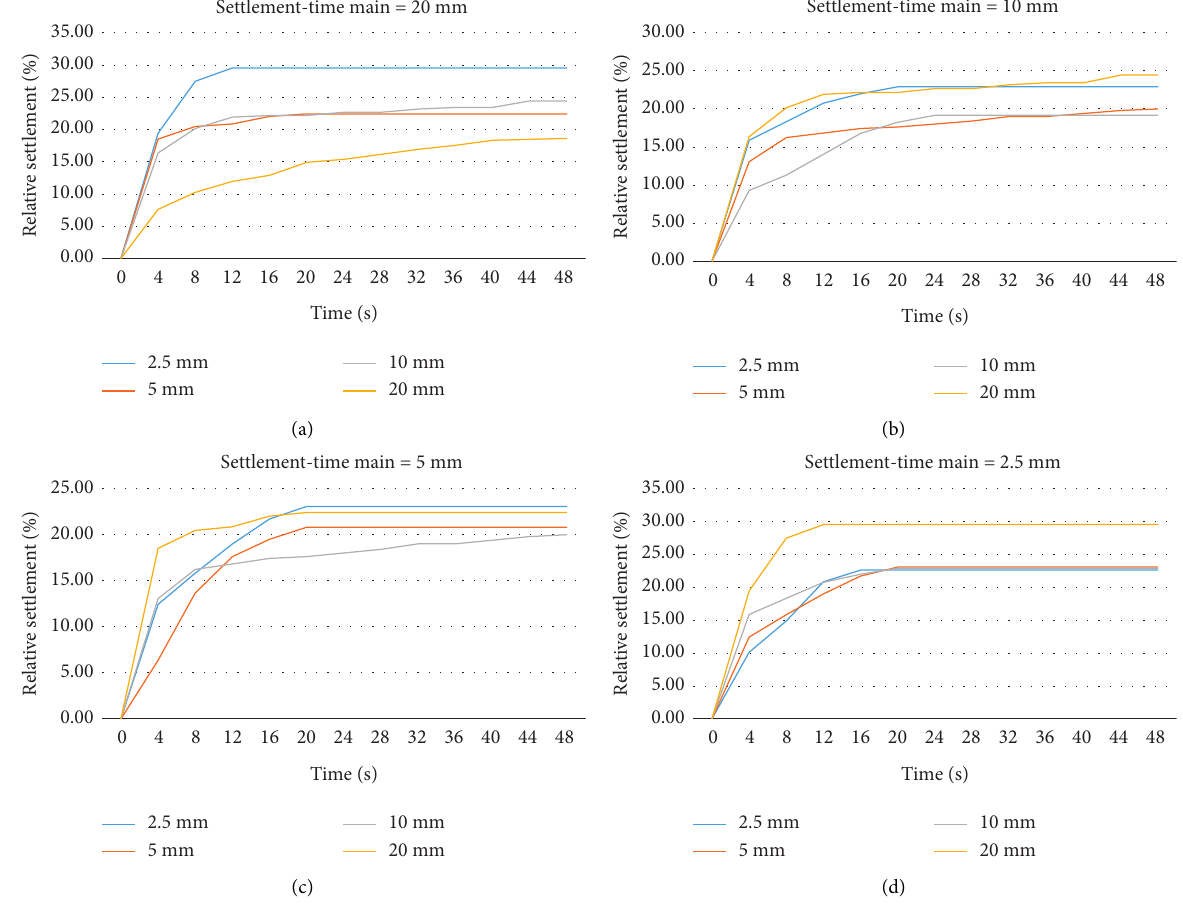
Figure 18: Percentage of relative settlement over time for sharp corner aggregates with a weight mixture equal to 2.5, 5, 10, and 20mm.